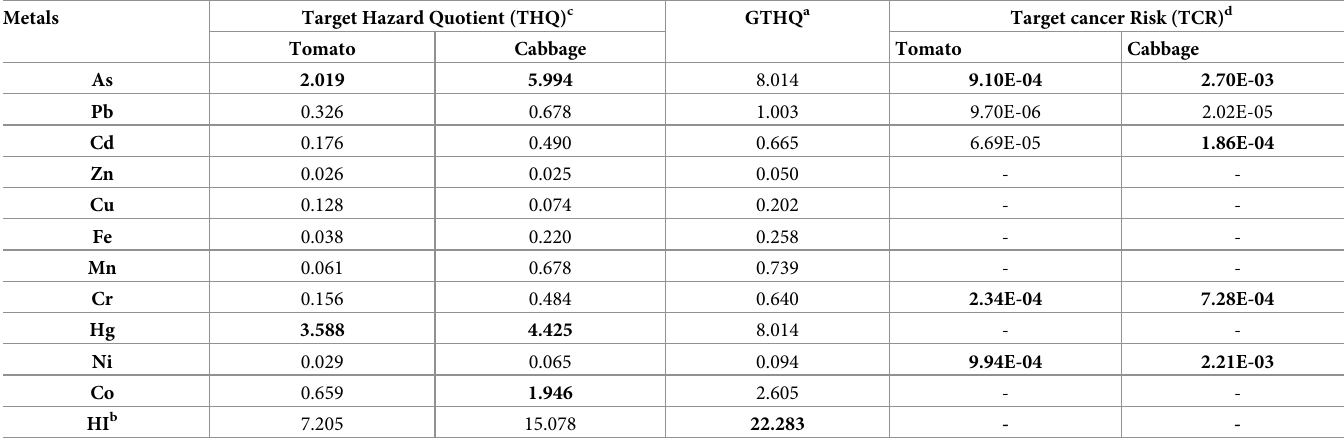
Table 7. THQ to heavy metals due to the consumption of contaminated vegetables (tomato and cabbage) for adults in Mojo area, central Ethiopia. Metals